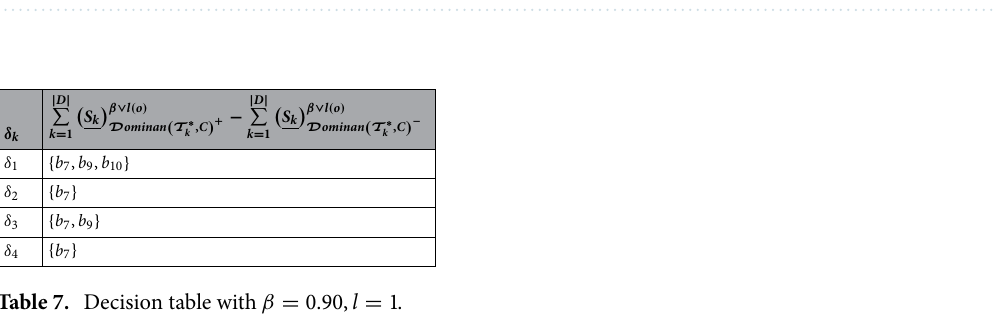
Table 6. The lower approximations table with β = 0.90, l = 1 .